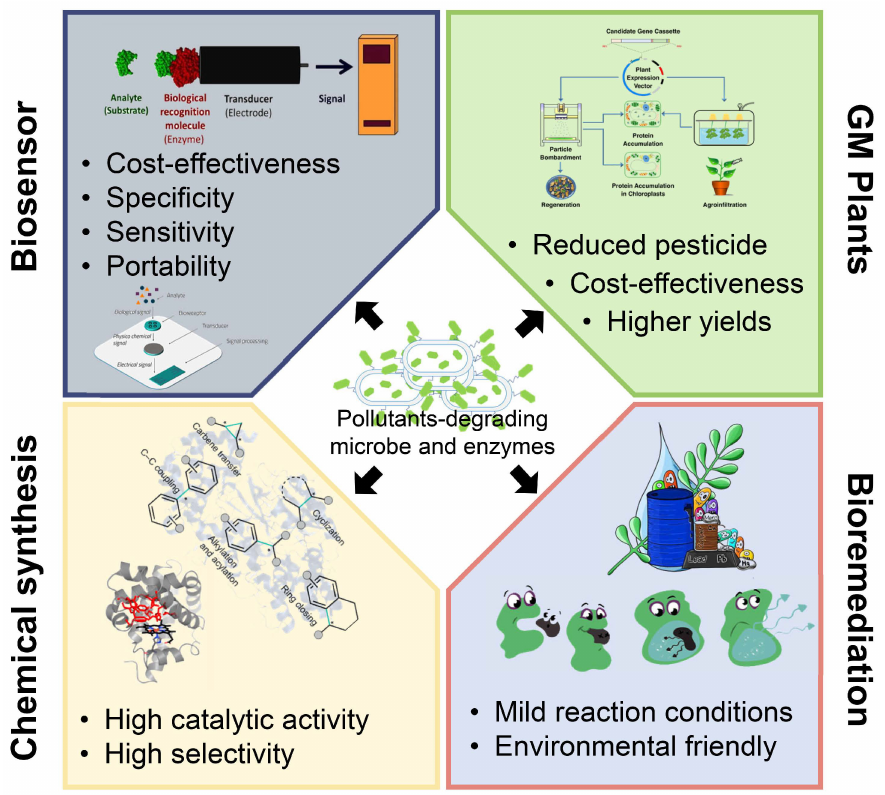
biosensors (Figure 5) due to their sensitivity, specificity, portability, cost-effectiveness, and the possibilities of their miniaturization [61].